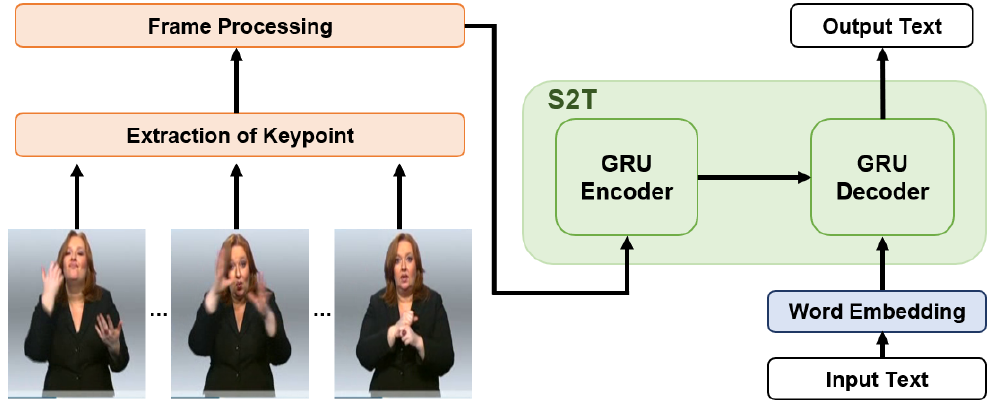
Figure 1. An overview of our approach. S2T means sign-language-to-text